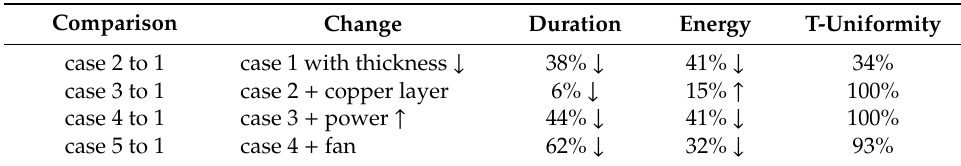
Table 4. Summary of the e ff ects of thickness, copper layer, microheater power, and active cooling on the microPCR performance (duration, energy consumed, and temperature uniformity); the values for duration and energy show the %